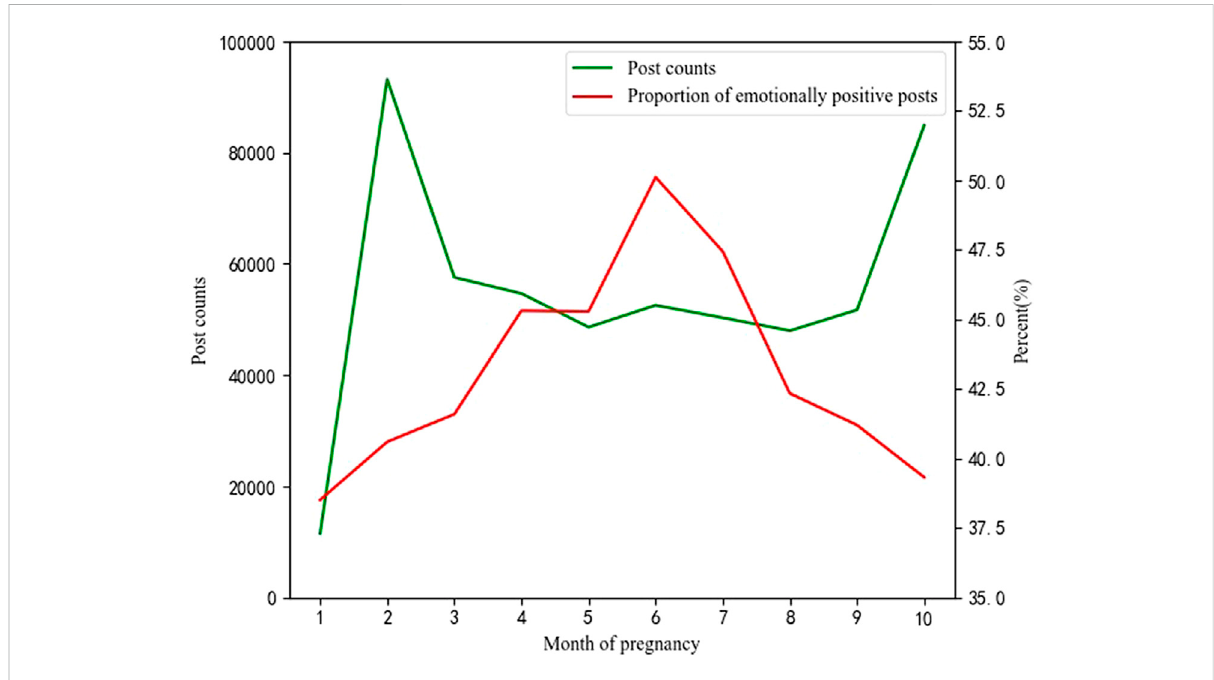
FIGURE 3 The results of sentiment